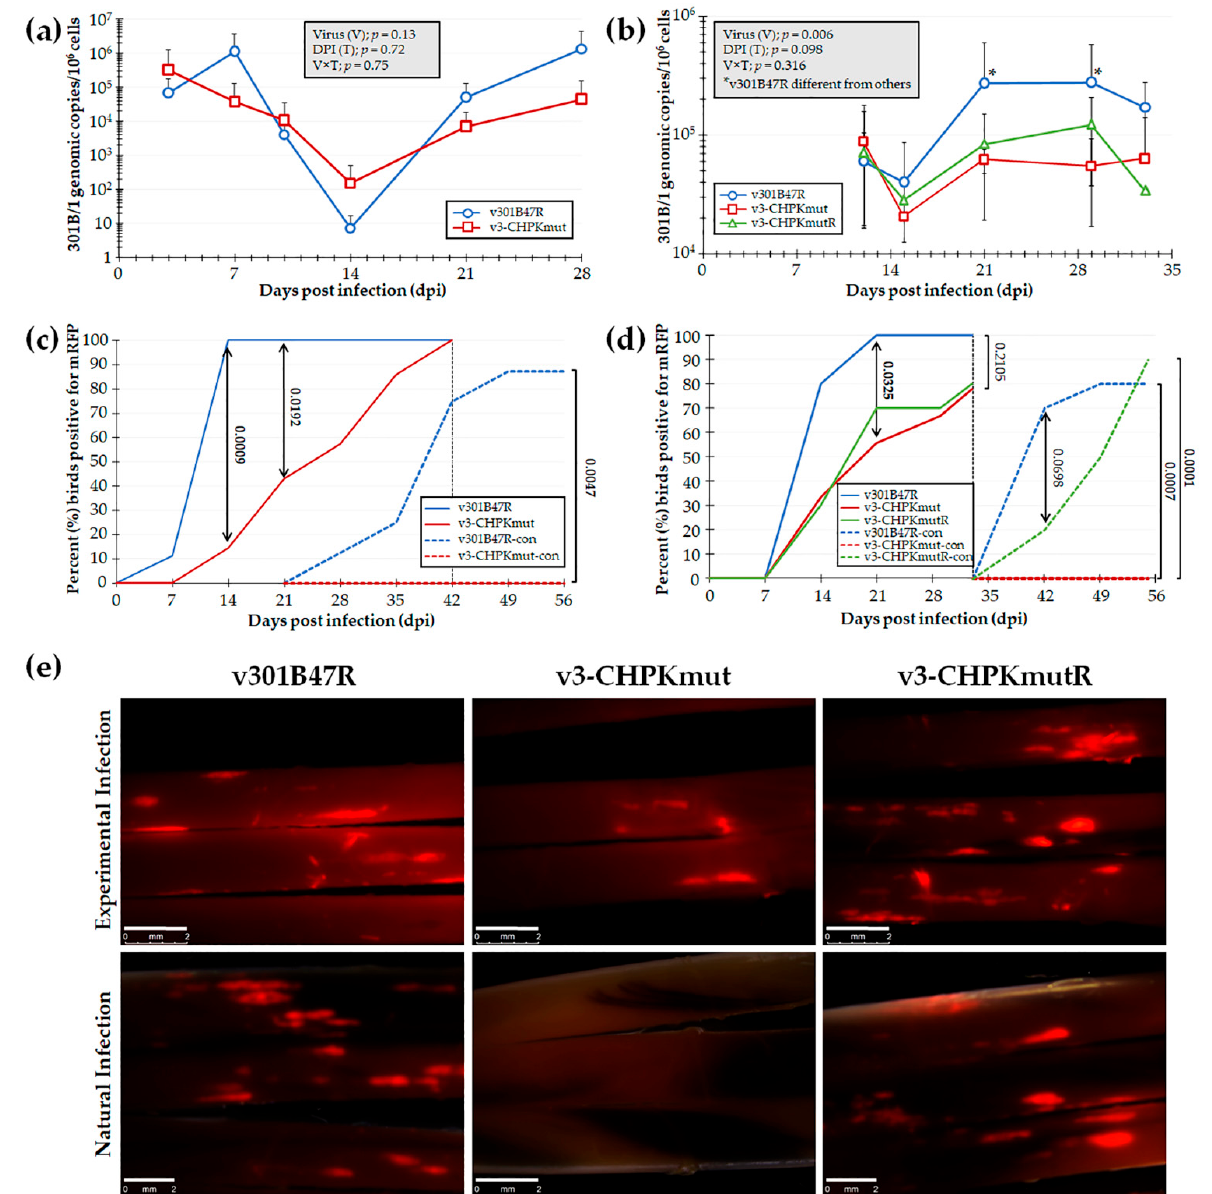
Figure 3. Replication and interindividual spread of r301B/1 viruses in chickens. Pure Columbian chickens were experimentally infected with v301B47R, v-3CHPKmut, or v3-CHPKmutR, as described in the Materials and Methods, in two experiments. ( a , b ) Replication was monitored in experimentally infected chickens by the quantification of 301B/1 genomes in blood over the first 4 ( a ) and 5 ( b ) weeks of infection. The mean 301B/1 genomic copies per 10 6 blood cells ± standard error of means are shown. Two-way ANOVAs were performed to check the significant effect of virus and time (dpi) and the associated interaction effect (V × D). ( a ) No significant differences ( p > 0.05, n = 109) were determined between both viruses. ( b ) Significant differences were seen ( p < 0.05, n = 75) between v301B47R and both v3-CHPKmut and v3-CHPKmutR at 21 and 29 dpi (*). Samples collected at 4 and 7 dpi lacked DNA and were excluded from data analysis. ( c , d ) Quantitative analysis of the percent of birds positive for pUL47mRFP in FFs over the course of both experiments. Using Fisher’s exact test at p < 0.05, there were no differences in the total percentage of experimentally infected birds infected at 42 ( c ) and 33 ( d ) dpi. No contact chickens housed with v3-CHPKmut-infected birds became infected in both experiments. ( e ) Representative feather follicles plucked from chickens experimentally and naturally infected with each virus in the second experiment. The white line represents a 2 mm scale bar.